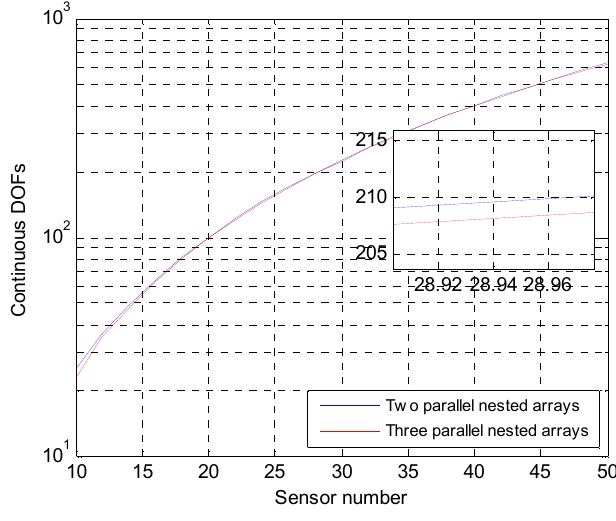
Figure 3. DOF comparison.